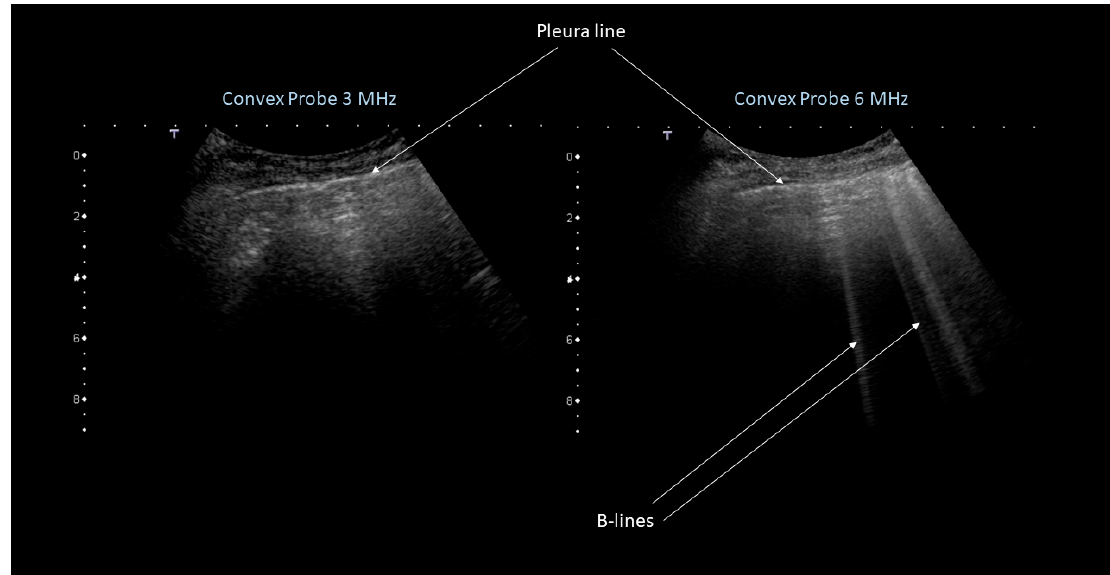
Figure 3. Ultrasound images obtained during patients investigation using a clinical scanner. The imaging frequency was varied from 3 MHz ( left ) to 6 MHz ( right ).